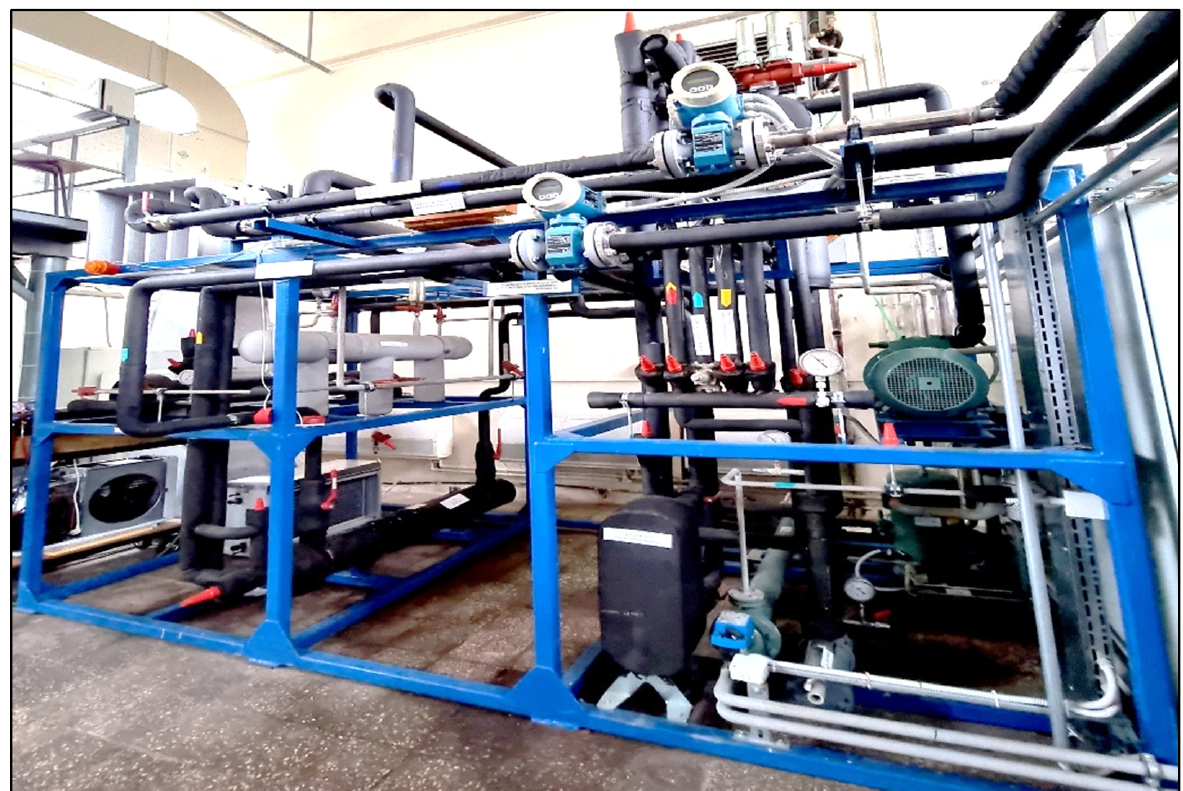
Figure 1. The experimental stand scheme. Source: own elaboration.